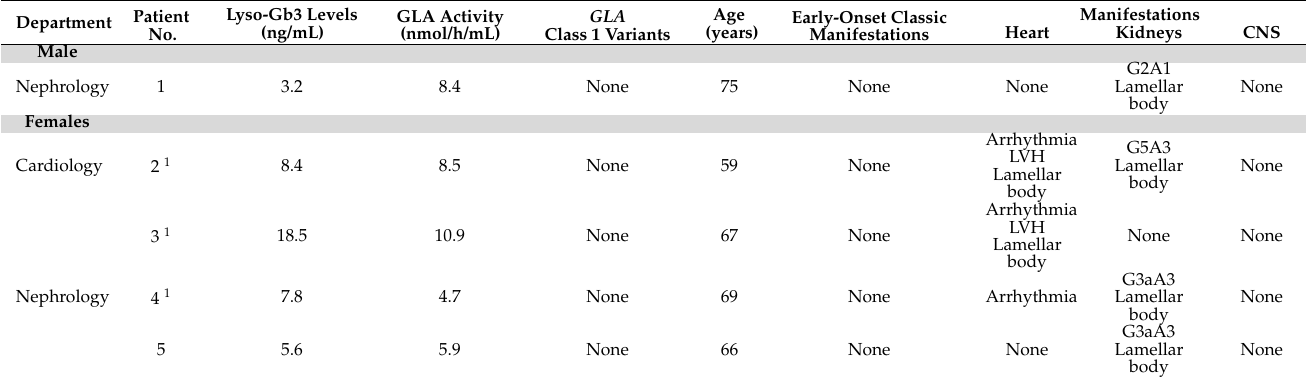
Table 4. Clinical manifestations in probands with late-onset biopsy-proven Fabry disease. Department Patient